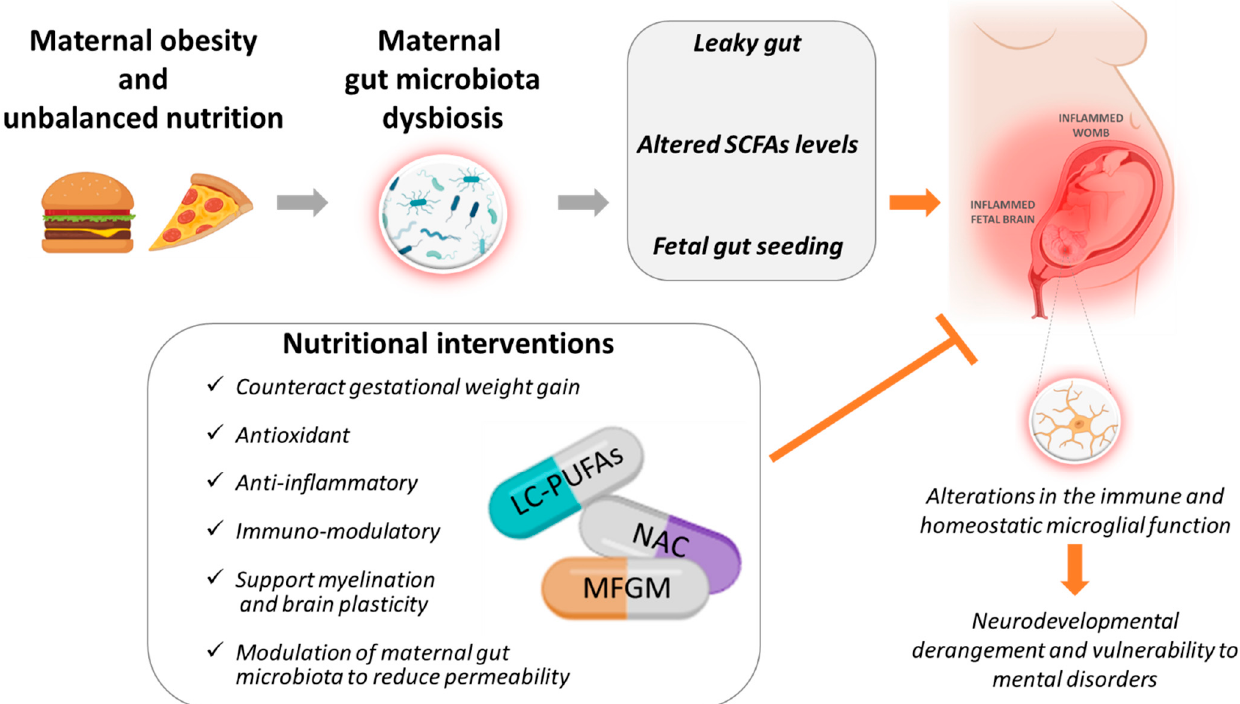
Figure 1. Obesogenic diets before and during pregnancy may trigger a dramatic loss of the homeostatic balance between the beneficial and potentially pathogenic bacteria in maternal gut leading to a condition of dysbiosis. This enhances gut inflammation that weakens the intestinal barrier (leaky gut) eventually resulting in the transplacental passage of bacteria and microbial compounds in the womb providing an immunogenic challenge to the fetus. SCFAs the main end-product of bacterial metabolism hold anti-inflammatory properties; they are tightly regulated during pregnancy to provide optimal fetal development. Obesity-related dysbiosis and inflammation may alter levels of SCFAs reaching the fetus. Finally, although still debated, the colonization of the fetal gut by maternally-derived bacteria (fetal gut seeding) in a condition of maternal dysbiosis might negatively affect the development of the gut-brain axis. The above-mentioned mechanisms may all contribute to provide a suboptimal intrauterine environment characterized by elevated systemic inflammation (inflamed womb) in turn affecting homeostasis in the developing fetal brain (inflamed brain) with microglia being a preferential target. Developing nutraceutical strategies, based on safe and feasible compounds (NAC, MFGM, LC-PUFA), aimed at counteracting gestational weight gain, reducing inflammation and oxidative stress is of paramount importance to support optimal brain development and to promote mental health throughout life. This image is original and has been created with